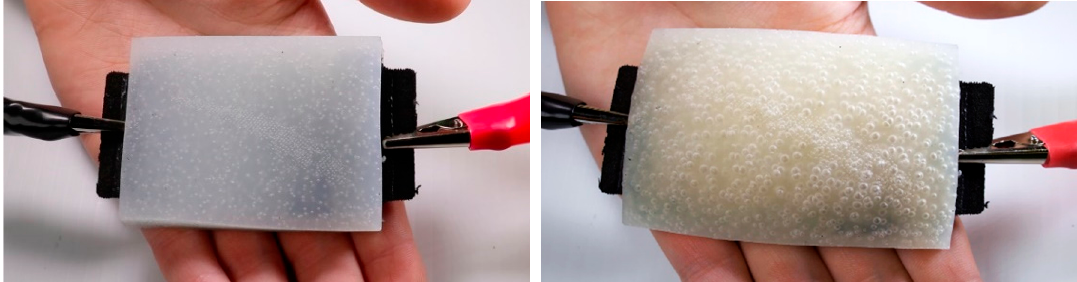
Figure 3. Silicone-ethanol actuator with fabric heater. The actuator shown is being thermally actuated, using an internal conductive fabric heating element (KL-6), connected to power supply. ( Left ) Initial state before actuation. ( Right ) Fully actuated actuator at 80 °C.